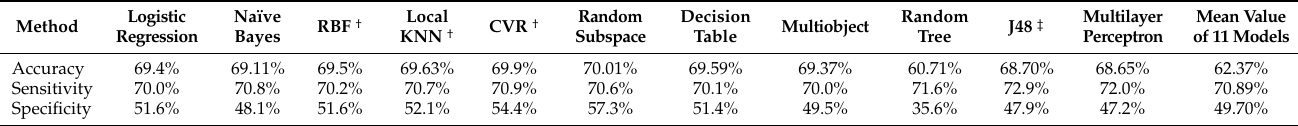
Table 2. Evaluations of accuracy, sensitivity, and specificity of 11 prediction models of overweightness and obesity. Method Logistic Regression